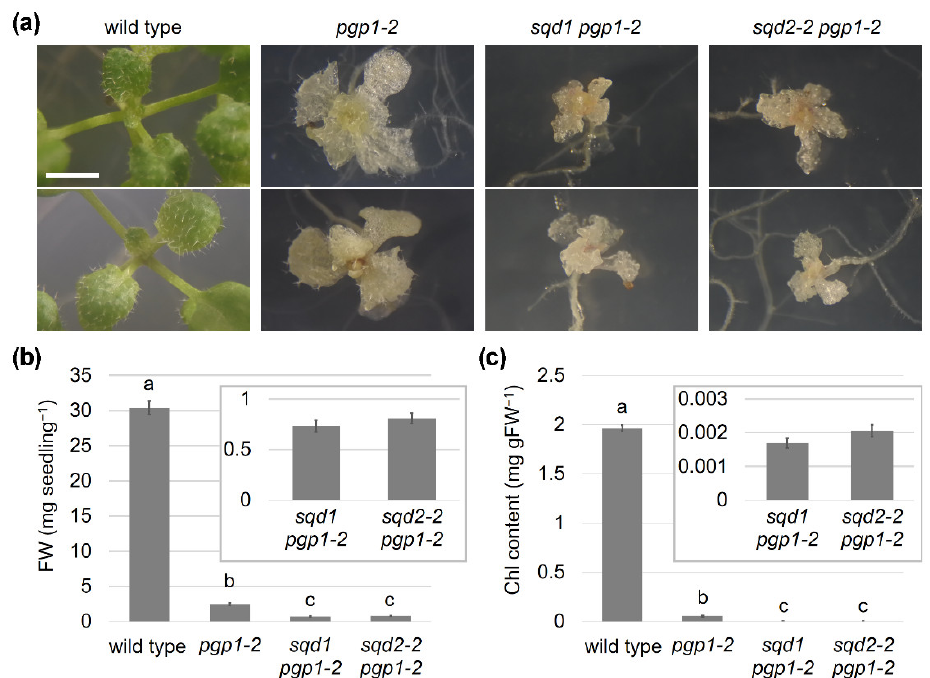
Figure 4. Growth defects of knockout mutants for anionic lipid biosynthesis in plastids. ( a ) Visible phenotypes of 24-d-old seedlings of mutants. Seedlings of 14-d-old wild type were shown for comparison. Two representative individuals were displayed for each line. Scale bar = 2 mm. ( b ) Fresh weight (FW) and ( c ) chlorophyll (Chl) content of the shoot of 14-d-old seedlings. Data are means ± SE of 24 independent samples. Insets focus the data for the sqd1 pgp1-2 and sqd2-2 pgp1-2 mutants. The data of wild type in Figure 1 was shown for comparison.